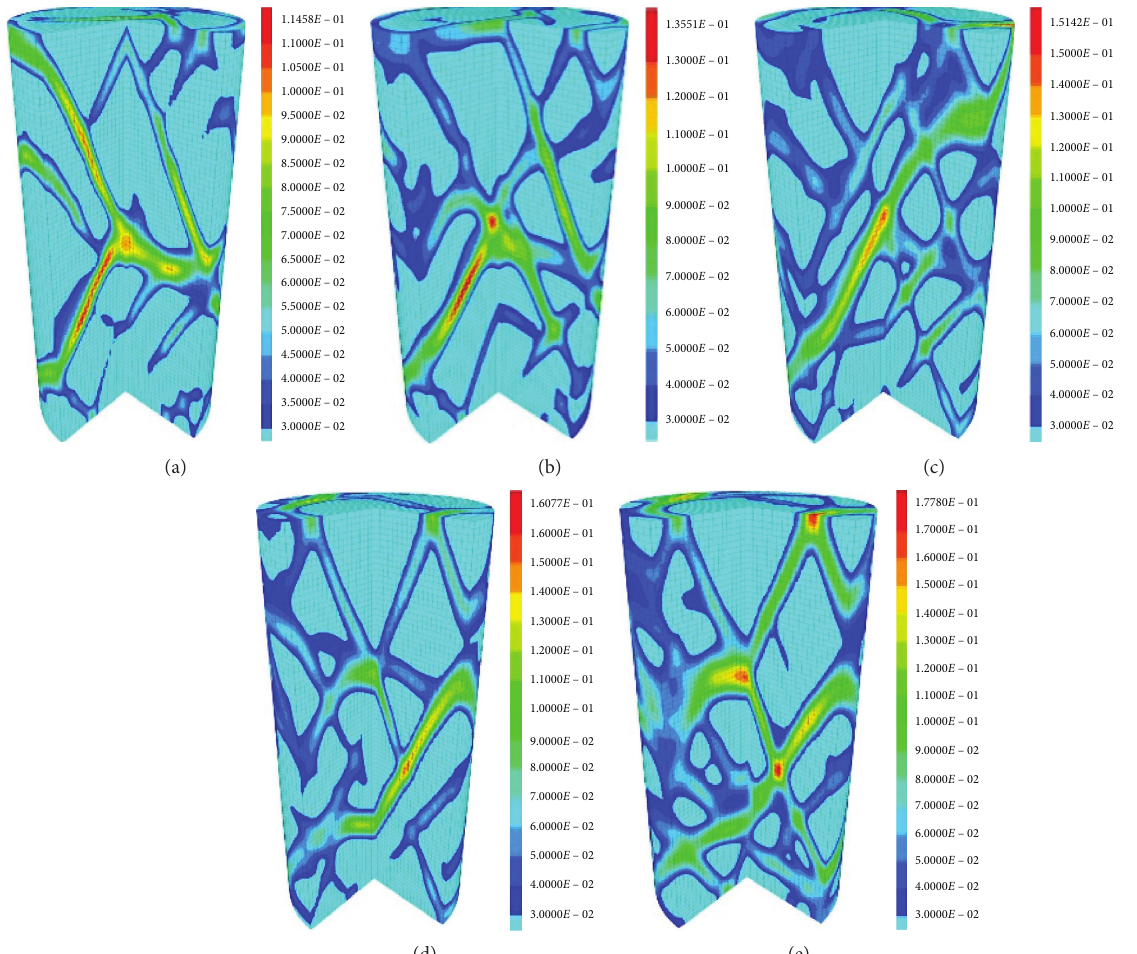
Figure 17: Shear strain ( ε s > 2%) after degradation under varied confining pressure. (a) σ 3 � 5 MPa. (b) σ 3 � 10 MPa. (c) σ 3 � 15 MPa. (d) σ 3 � 20 MPa. (e) σ 3 � 30